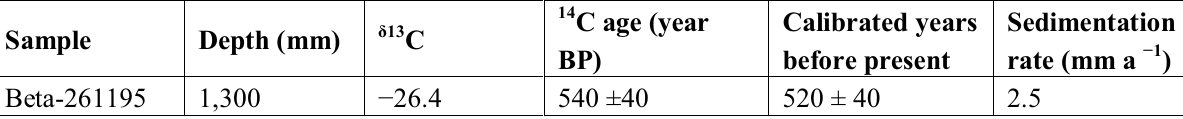
Table 4. Radiocarbon dating results from Moukouke Island core, Cameroon